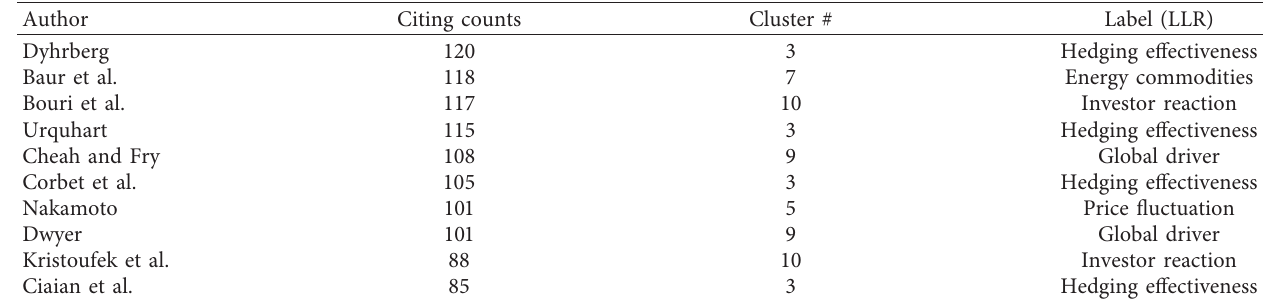
Table 8: Most cited